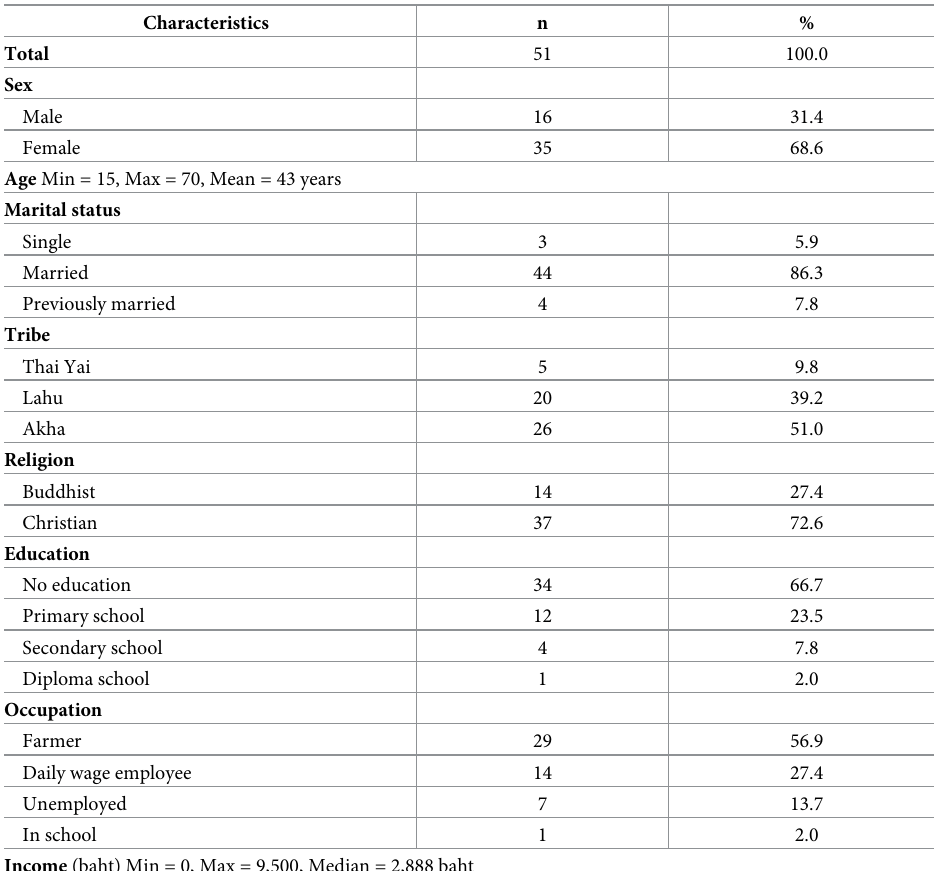
Table 1. Demographic data of the participants.